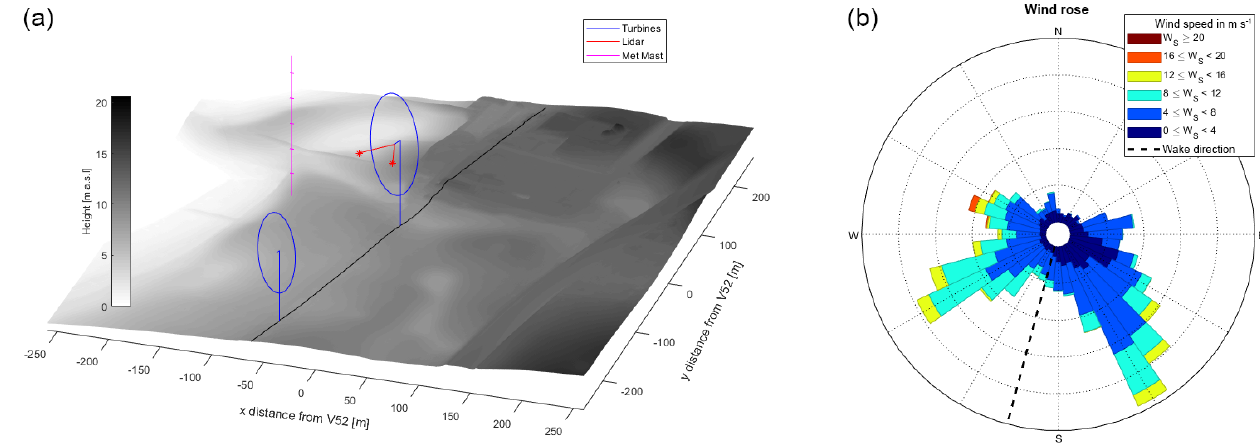
Figure 3. (a) Digital terrain model (DTM) of the Technical University of Denmark’s (DTU) test site at Risø where the two turbines and the lidar are also shown. The black line indicates the wake direction of 195 ◦ . Zone 32 UTM coordinates centred at the Vestas V52 turbine were used. The DTM data were obtained from the Danish Map Supply (Agency for Data Supply and Efficiency, 2018). (b) Wind rose derived from sonic anemometer measurements on the meteorological mast during the experiment. The dashed black line indicates the direction of the Nordtank